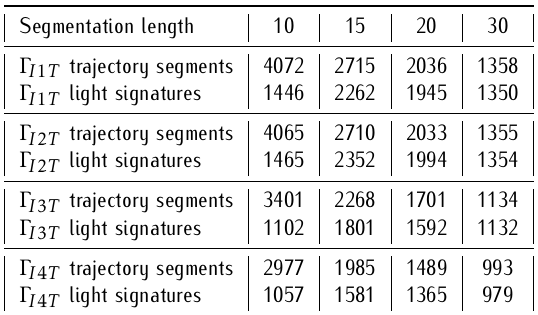
Table 4. Number of light intensity segments and unique light signatures with various segmentation lengths for Timis Deva (I) trajectory